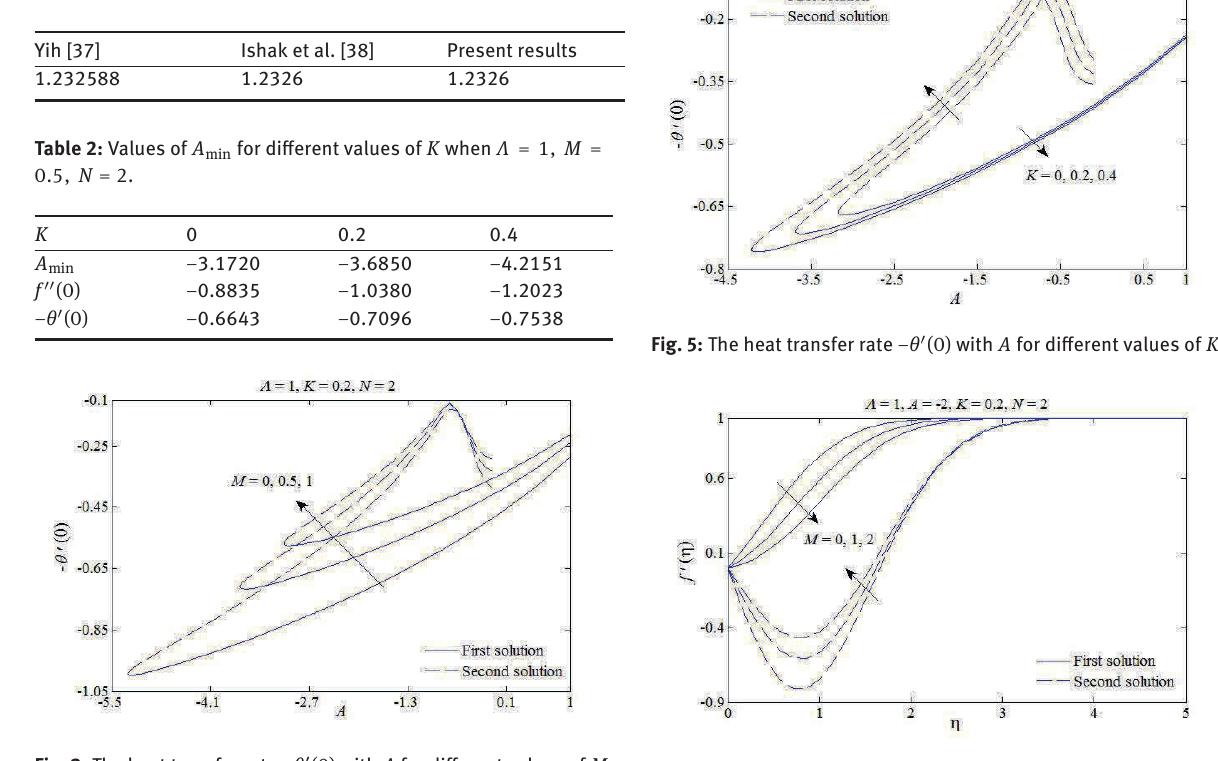
Fig. 6: Velocity profiles for different values of M .